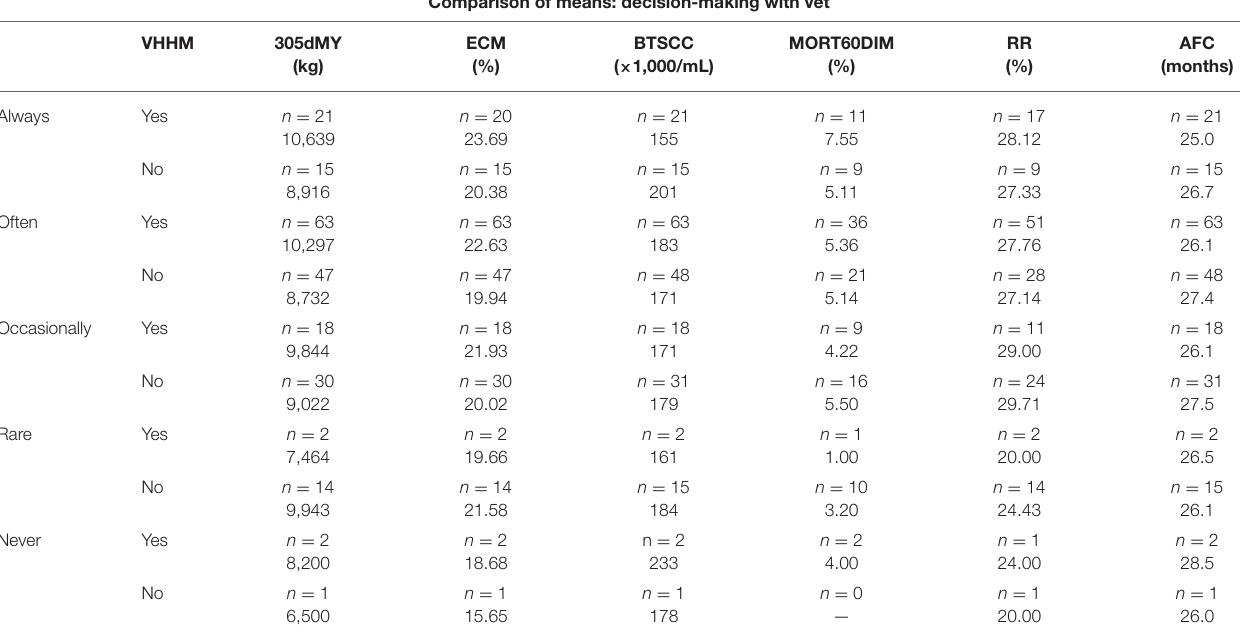
TABLE 2 | Descriptive data of decision-making with veterinarian. Comparison of means: decision-making with